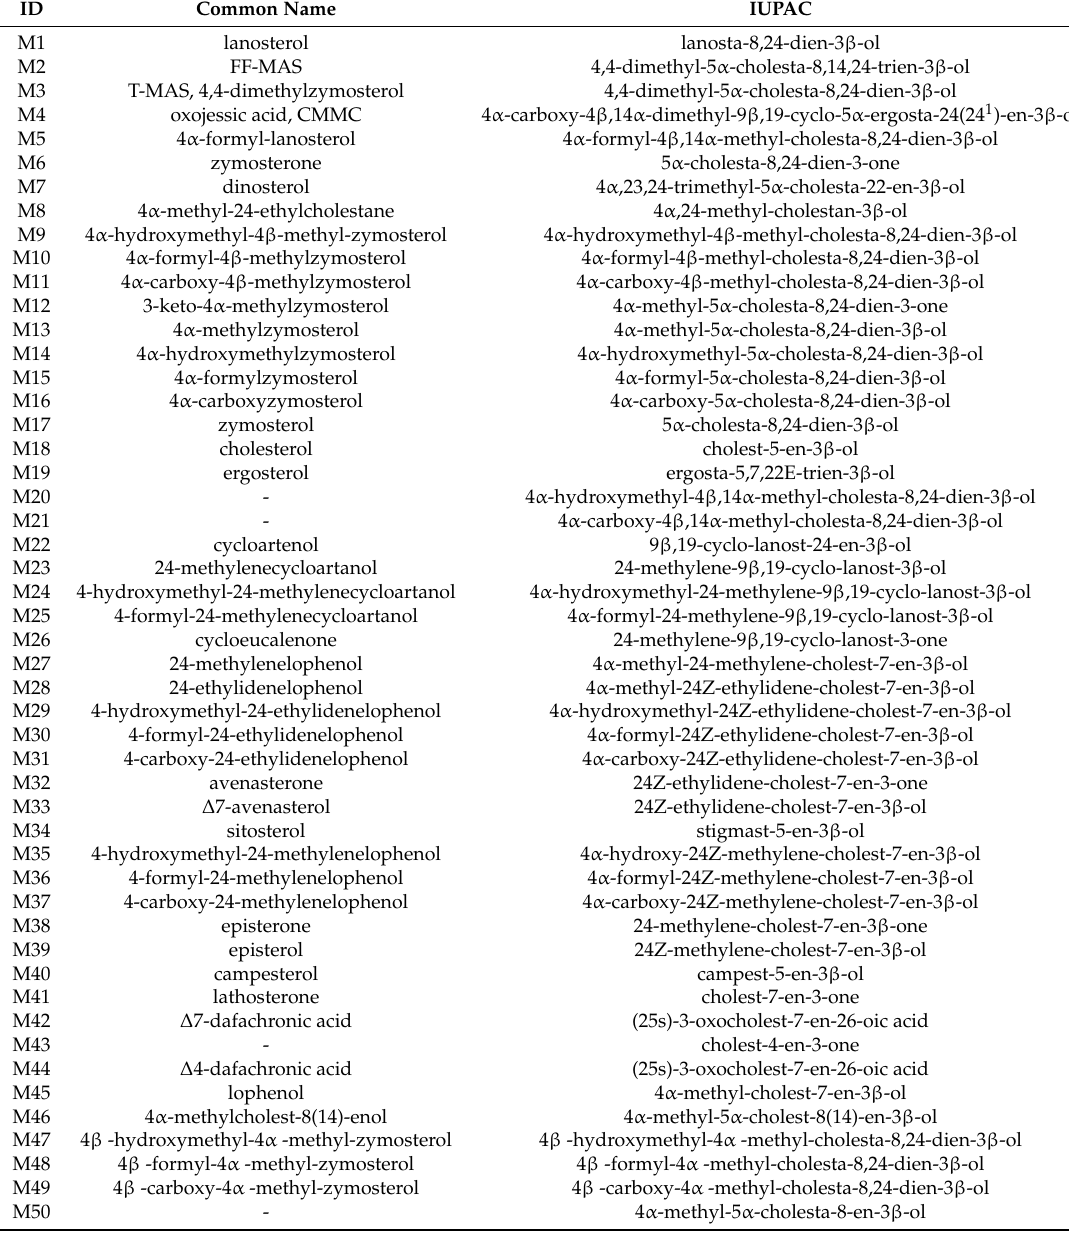
Table 1. IUPAC sterol nomenclature